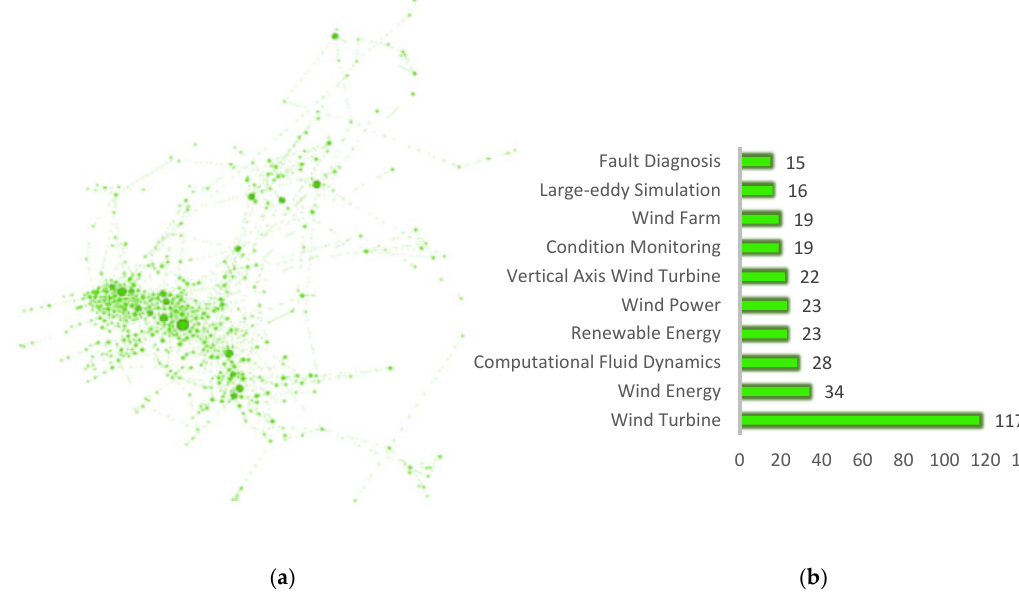
Figure 18 . Wind power community layout: ( a ) manuscripts published, ( b ) keywords. Figure 18. Wind power community layout: ( a ) manuscripts published, ( b )